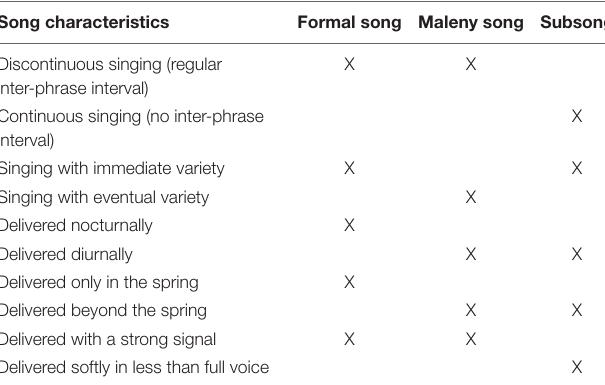
TABLE 4 | A comparison of species-typical song characteristics in pied butcherbird formal song, the Maleny song event, and subsong. Song